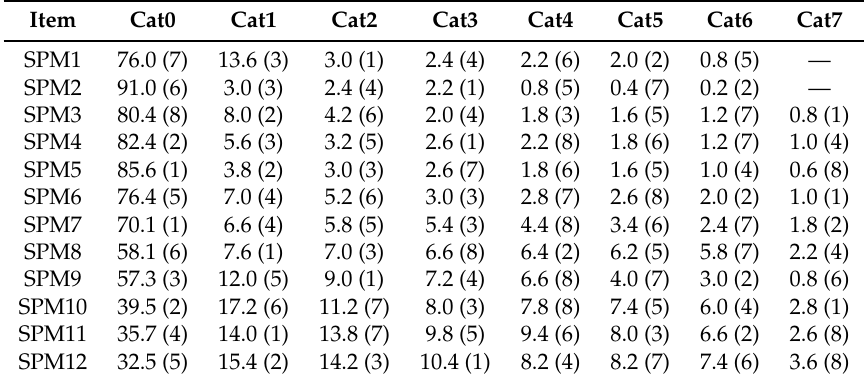
Table 9. The last series of Raven’s standard progressive matrices (SPM-LS) polytomous data: percentage frequencies and recoding